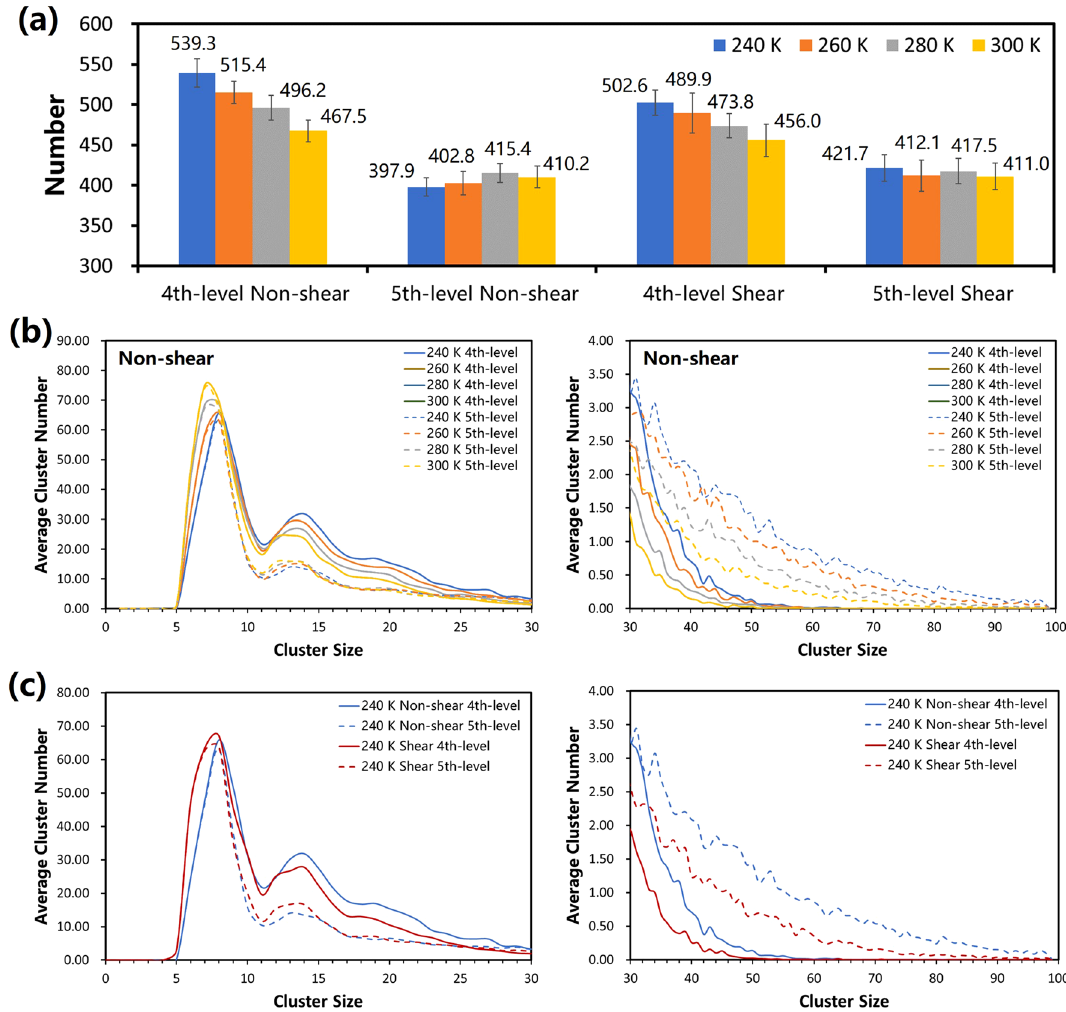
Figure 4. The distribution of hierarchical structures at the 4th and 5th levels in the network in various cases. ( a ) The average number of 4th and 5th-level clusters at various temperatures. ( b ) The average distribution of 4th- and 5th-level cluster sizes at various